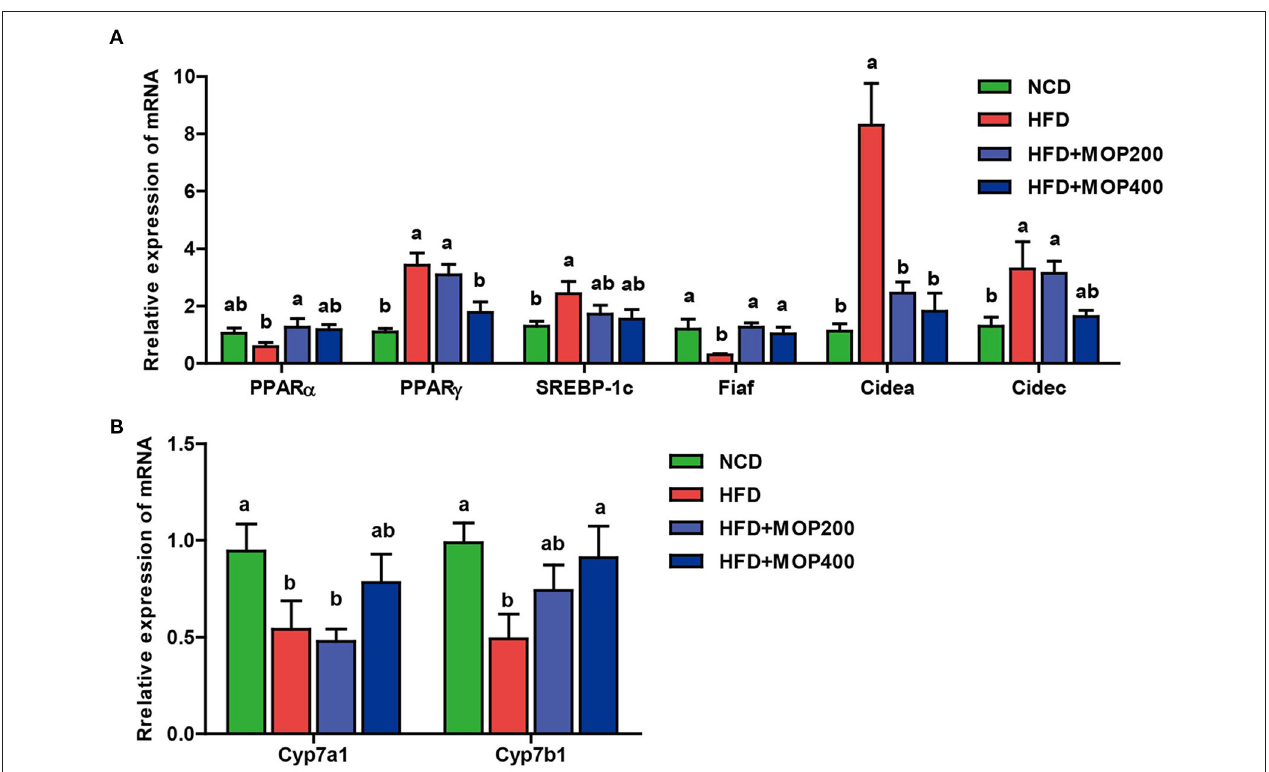
FIGURE 5 | MOP regulates the mRNA expression levels of genes involved in lipid metabolism and bile acid synthesis in the liver. (A) Relative mRNA expression levels of genes involved in lipid synthesis; (B) Relative mRNA expression levels of genes involved in bile acids metabolism. The data are expressed as means ± SEM ( n = 6). Bars marked with different superscript letters (a-c) indicate significant differences at p < 0.05 based on one-way ANOVA with Duncan’s post-hoc